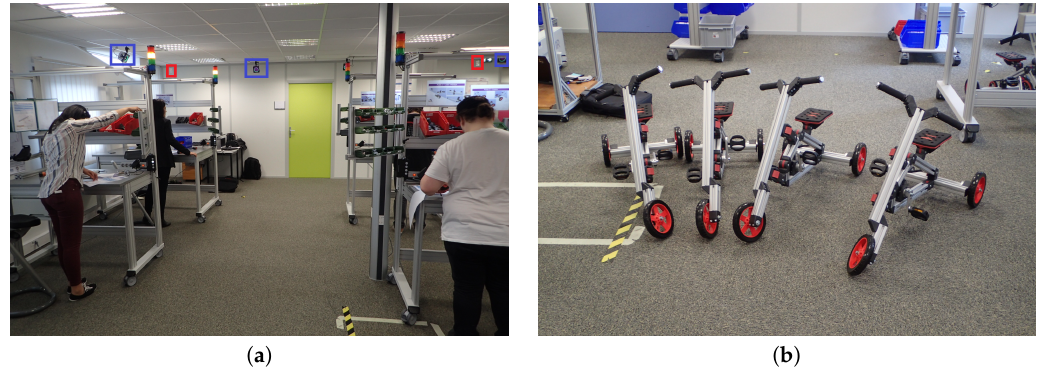
Figure 3. Final assembly of tricycles, and during the process in a NLOS industrial condition made in a workshop. ( a ) Front view of the assembly process. In the red square is the UWB system and in the blue square is the MoCap system. ( b ) Result of the assembly process.